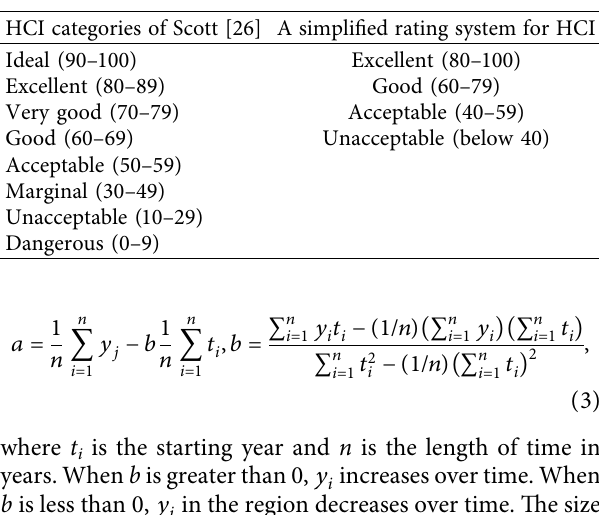
Table 3: HCI’s rating scheme. Table 4: Annual average tourist climate comfortable period in